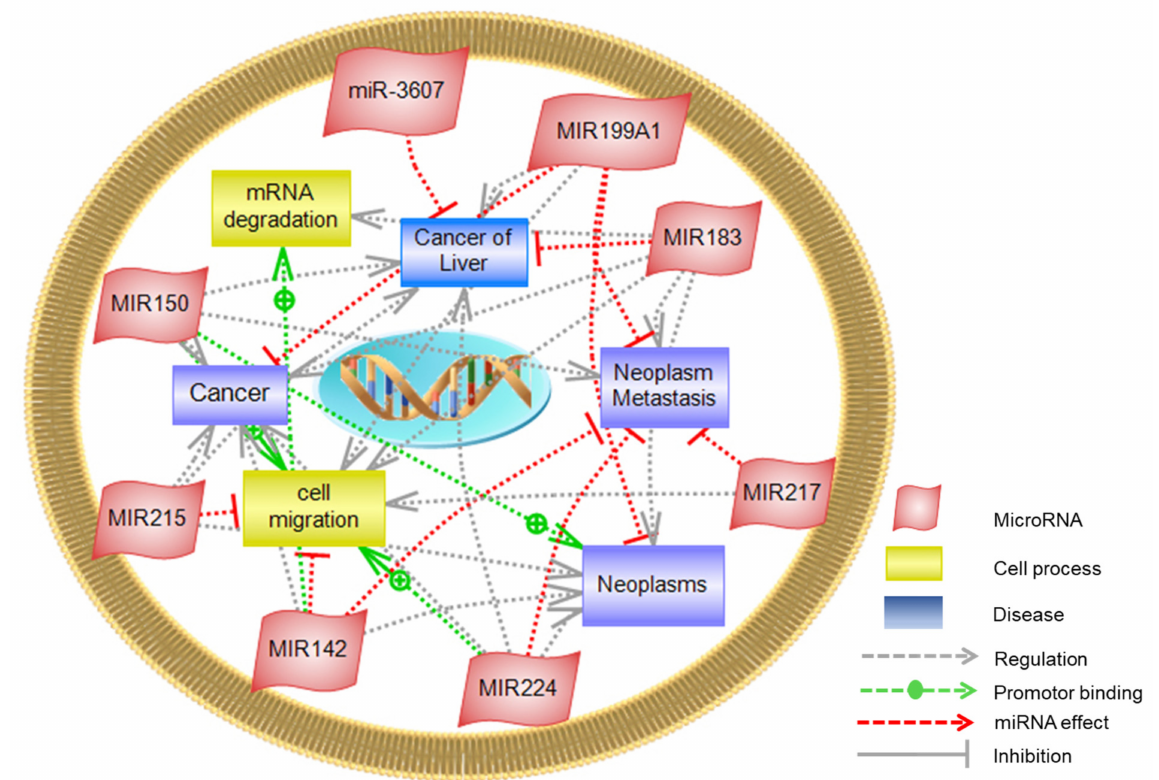
Figure 17. Altered miRNA-Molecular functions and Biological Processes. The global untargeted affected pathways involving: cell migration and mRNA degradation resulting in different cancer types, especially liver cancer, neoplasms, and neoplasm metastasis, implicated in the miRNAs’ alteration (miR-142, miR-150, miR-183, miR-199a, miR-217, miR-224, and miR-3607). Furthermore, the most relevant targeted pathways of liver carcinogenesis are hepatitis C infection, HCC, and metastasis (Figure 18). Our pathway analysis showed that miR-183, miR-199a, miR-215, and miR-224 play a significant regulatory role in HCC development, while the sequence of miR-3607 exhibits a binding site that inhibits the progression of HCC. Alteration in miR-199a expression affects cellular functions and indirectly contributes to liver carcinogenesis by regulating HCV infection. While the expression of miR-183 is dysregulated in liver cirrhosis, premalignant lesions, and HCC, it directly inhibits the tumor suppressor gene in liver carcinogenesis. MiR-224 exhibits overexpression in HCC and contributes to the development of liver